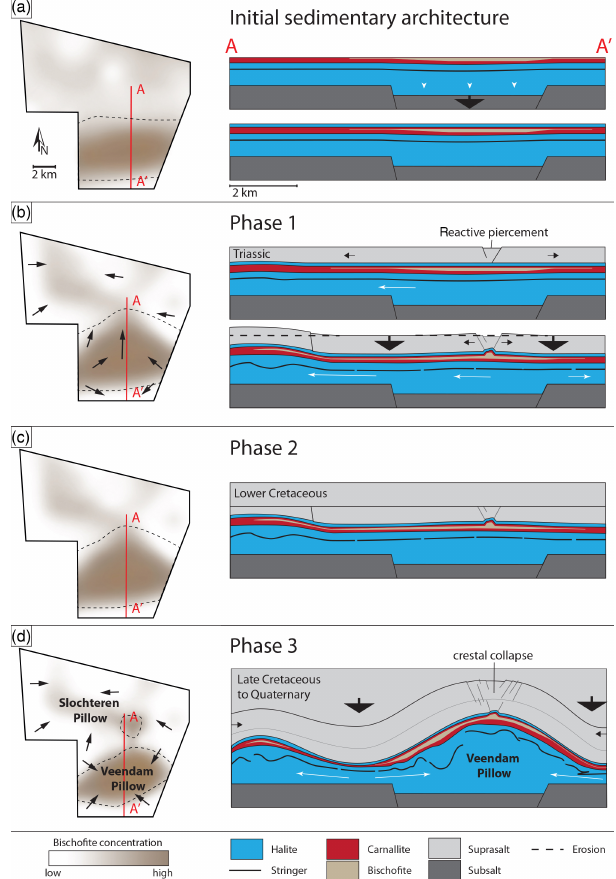
Figure 8. Conceptual sketch (depth not to scale) of salt deforma- tion in the study area: maps on the left indicate movements in the bischofite deposit; the profile sketches on the right side indicate corresponding deformation of the Zechstein (incl. ZIII AC stringer and K-Mg salts) and the suprasalt sediments. Black arrows indicate movements in the suprasalt sediments (e.g., extension and subsi- dence), white lines movements in the salt (e.g. salt withdrawal be- low sediment basins): (a) tectonic movements in the subsalt allow for localized bischofite deposition in the area of the later Veendam Pillow; (b) differential loading and extension in the Triassic sedi- ments and during Jurassic erosion cause salt withdrawal and boud- inage of the ZIII stringer in the area of the later Veendam Pillow, while salt accumulation and doming farther north triggers the for- mation of the Slochteren Pillow; K-Mg salts are initially deformed by extensional features in the salt’s overburden; (c) no deformation during stable phase 2; (d) ongoing subsidence and salt withdrawal below sedimentary basins cause the formation of the Veendam Pil- low and further grow of the Slochteren Pillow. The bischofite de- posits are dragged into the Veendam Pillow, where they deform due to ZIII stringer deformation and structures in the